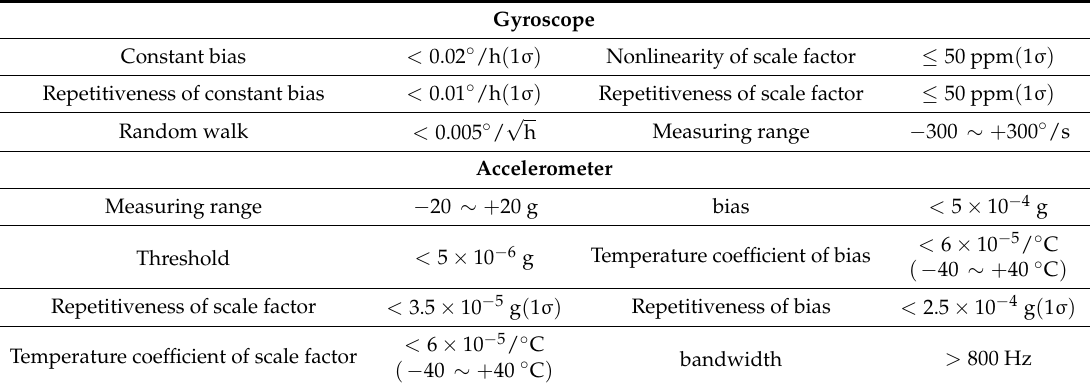
Figure 13. ( a ) Turntable and IMU; and ( b ) construction of turntable test. Table 7. Sensor